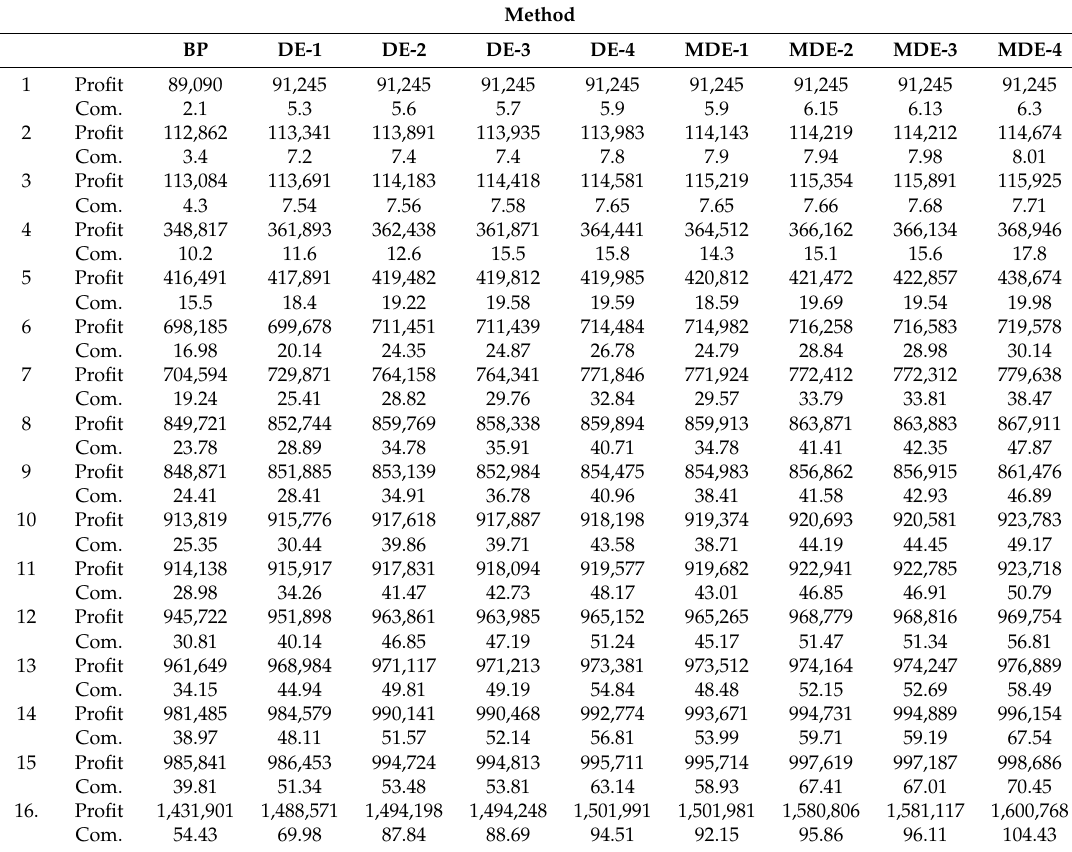
Table 14. Profit and computational time generated by all methods.